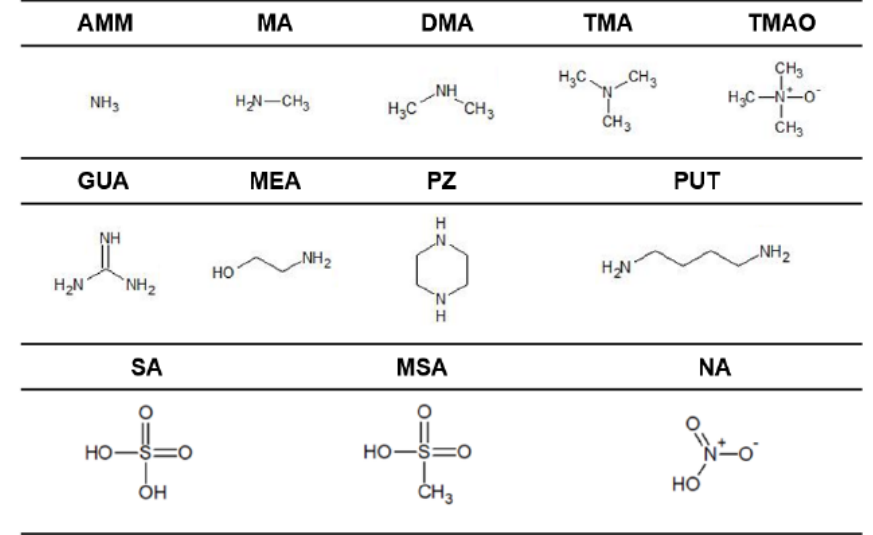
Table 1. Acid and base compounds in this study. Abbreviations are as follows: ammonia (AMM), methylamine (MA), dimethylamine (DMA),